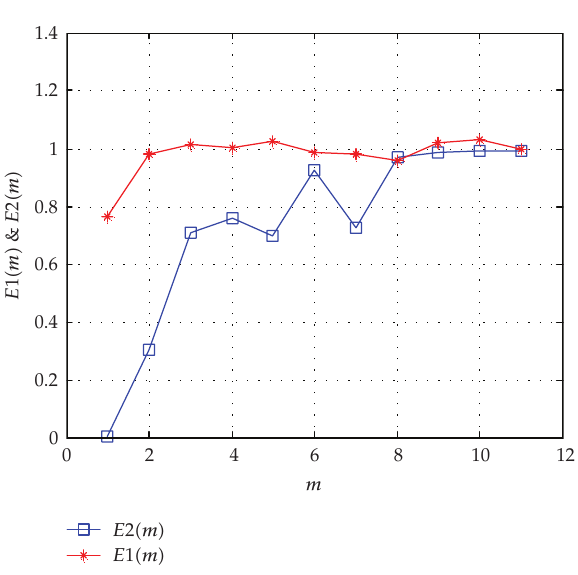
Figure 1: The values E 1 (cid:6) m (cid:7) and E 2 (cid:6) m (cid:7) for the data from the retailer’s